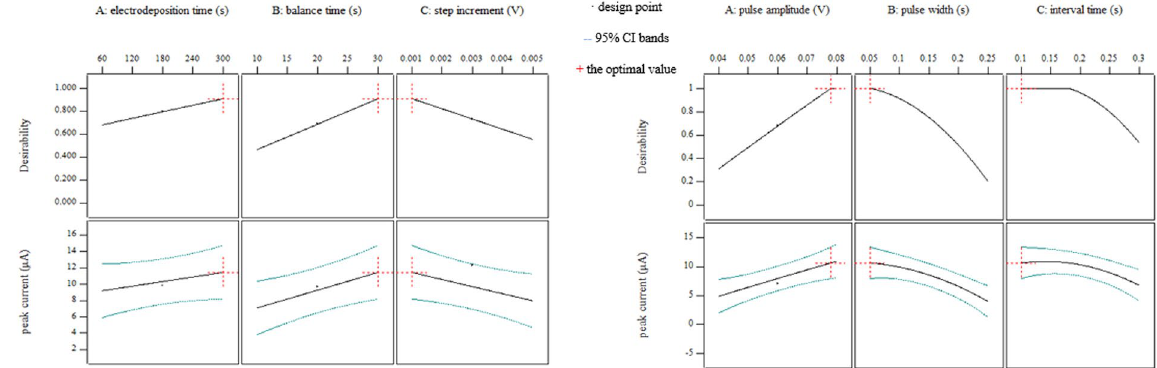
Figure 2. Desirability and 95% prediction intervals of electrodeposition time, balance time, step increment, pulse amplitude, pulse width and interval time in 0.1 mol/L acetate buffer.